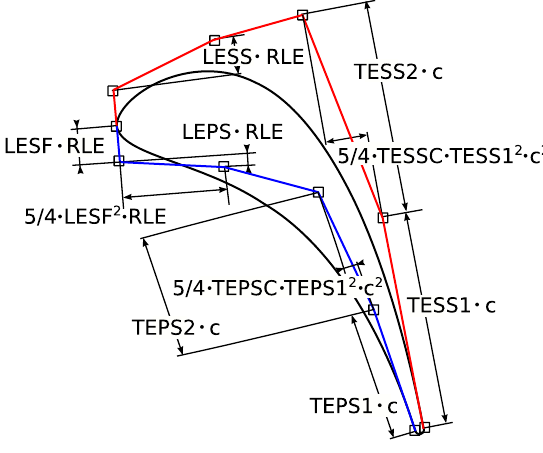
Fig. 1. Length parameters of the profile parameterization.